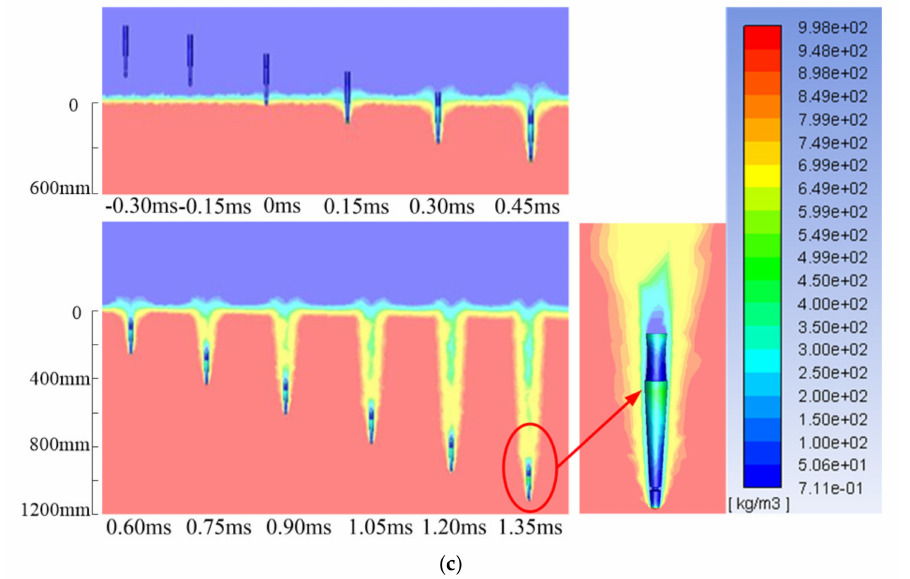
Figure 17. Contours of the cavity of water-entry withdi ff erent α : ( a ) α = 60 ◦ ; α : ( b ) α = 90 ◦ ; α : ( c ) α = 120 ◦ .